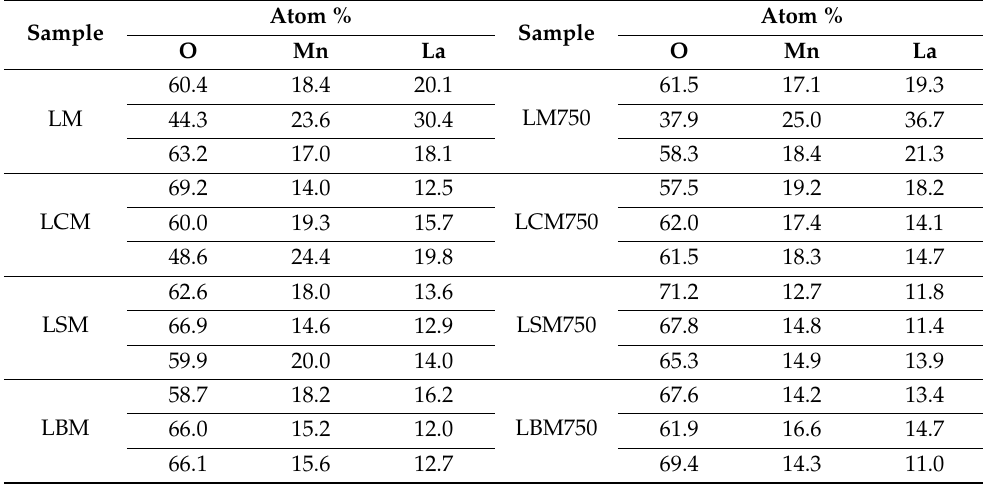
Table 4. Atom % obtained by EDS corresponding to the points indicated in the SEM images shown in Figure 8.